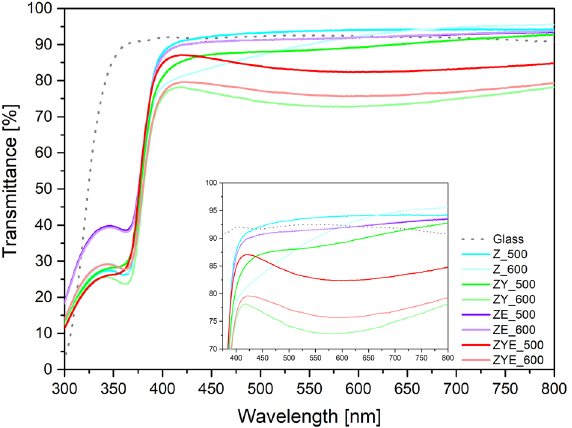
Figure 7. Transmittance spectra of ZnO and rare earth metal oxide-doped ZnO thin films.